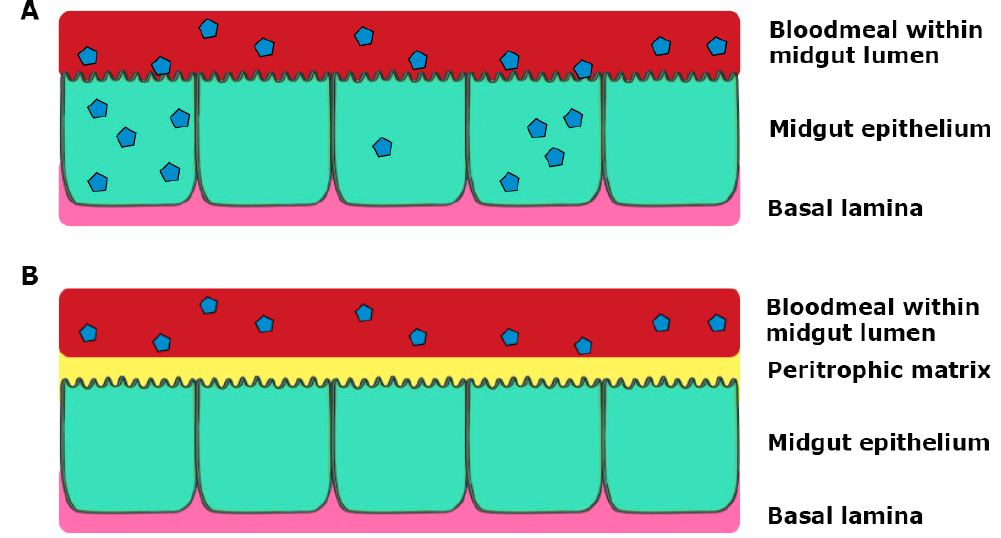
Figure 3. Schematic representation of infection of the midgut, where virus particles are represented as blue polygons. ( A ) Virus in the bloodmeal infects epithelial cells through the microvilli and replicates; ( B ) Virus in the bloodmeal fails to infect the epithelial cells prior to secretion of the peritrophic matrix by midgut epithelial cells during blood digestion.